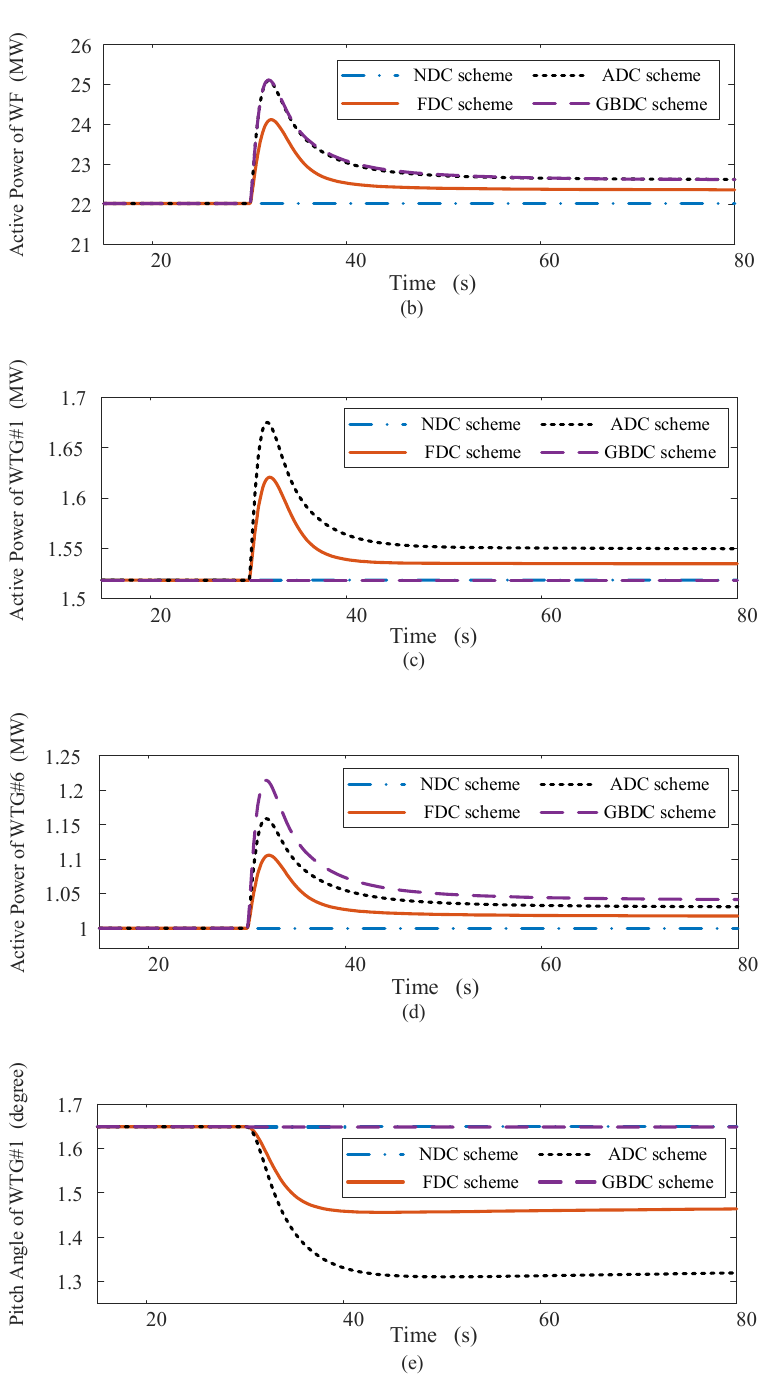
Figure 11. Simulation results of Case 1: ( a ) system frequency; ( b ) active power of WF; ( c ) active power of WTG#1; ( d ) active power of WTG#6; ( e ) pitch angle of WTG#1.